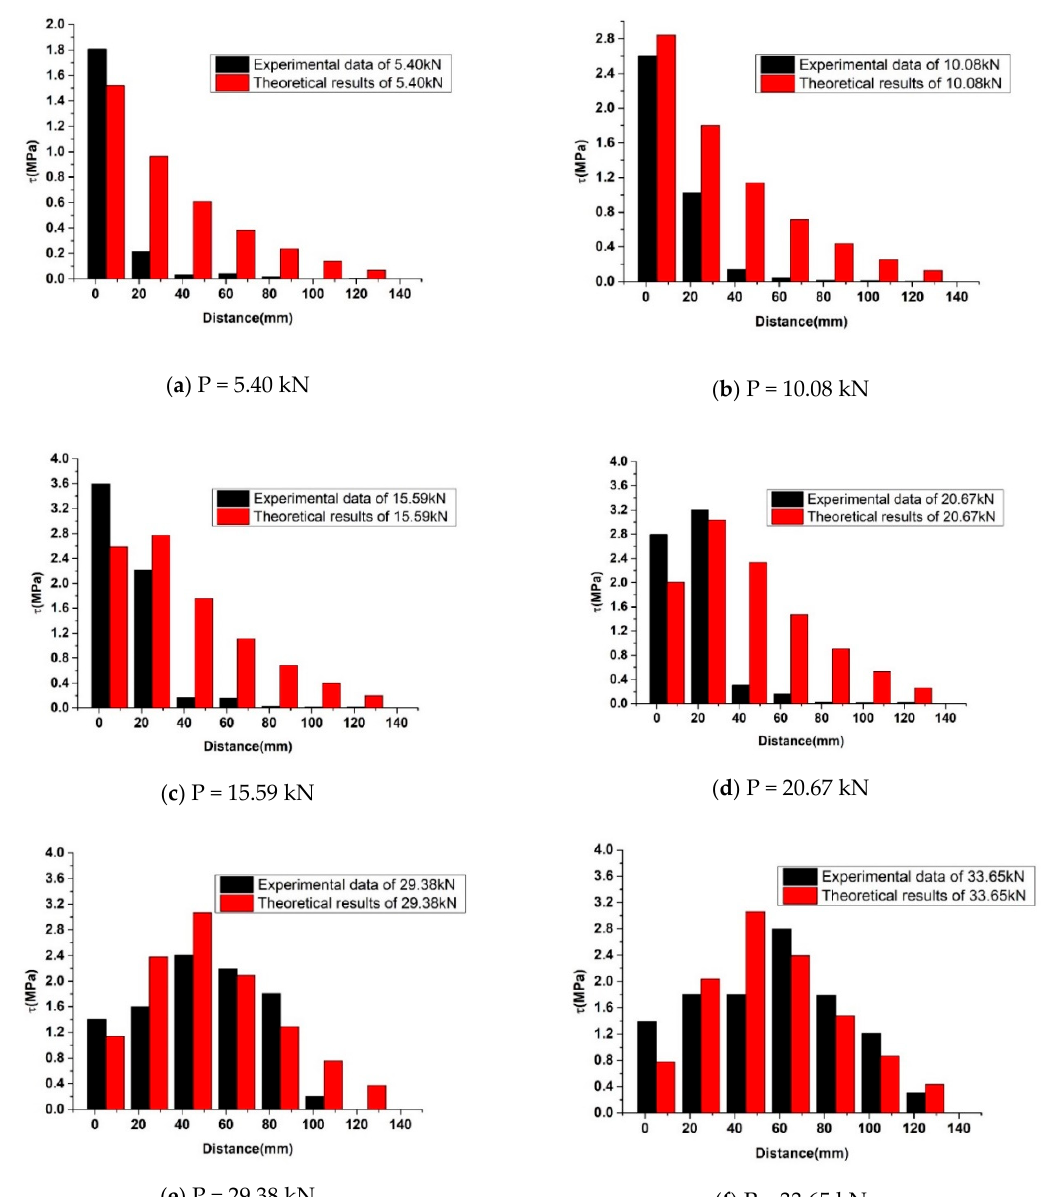
Figure 15. Comparison of analytical and test results of specimen NE-CFRP-180.